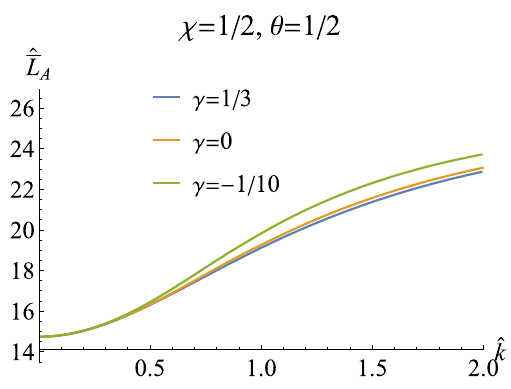
Fig. 10 The Lorentz ratios deski parameter